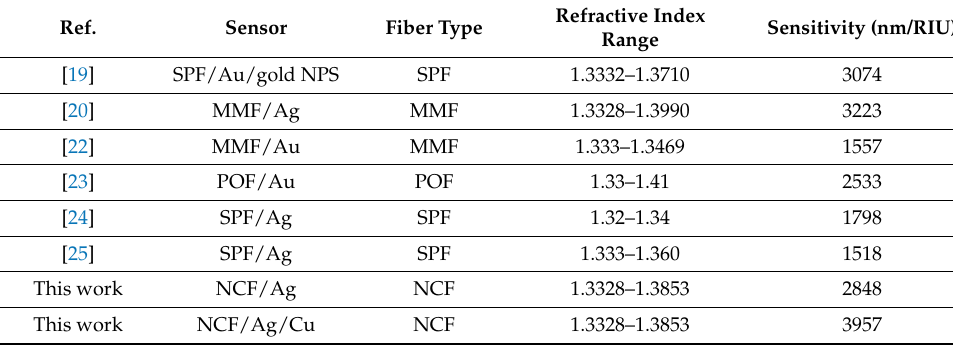
Table 2. Comparison with the SPR refractive index fiber sensor reported in the experiment.